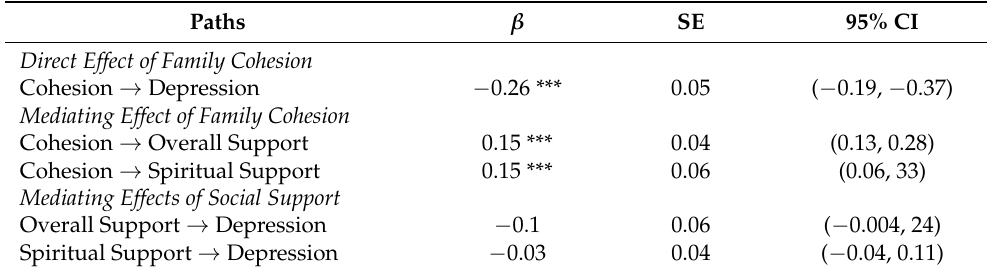
Table 3. Direct and indirect effects of family cohesion and social support on